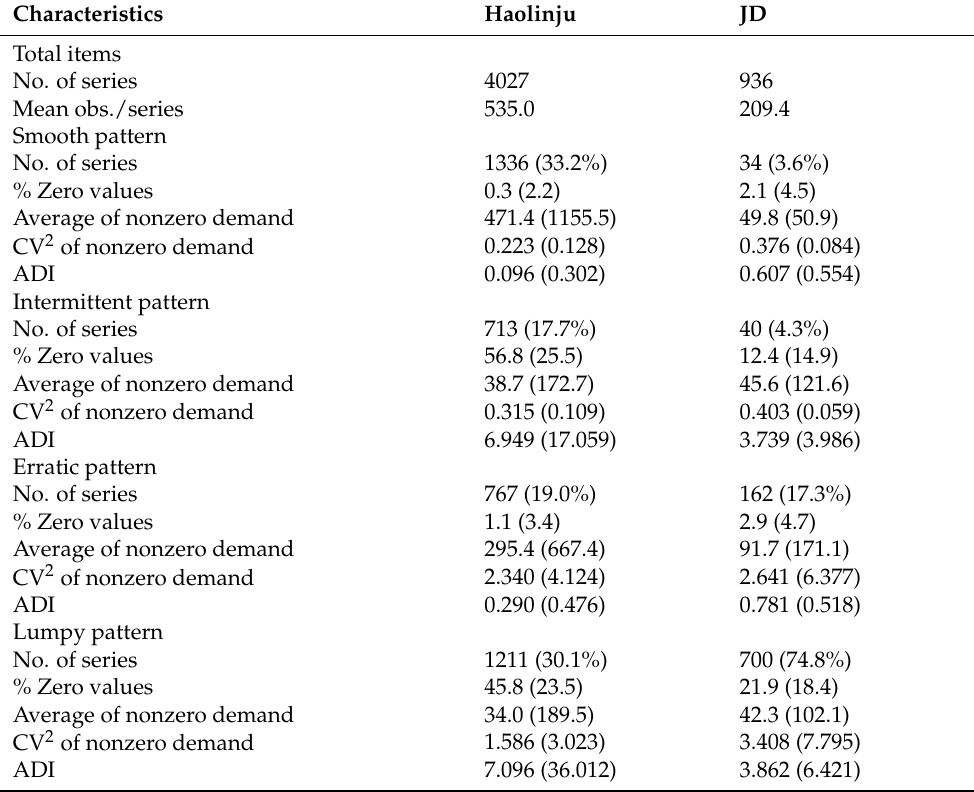
Table 2. Characteristics of the sales of the offline retailer (Haolinju) and the online retailer (JD).